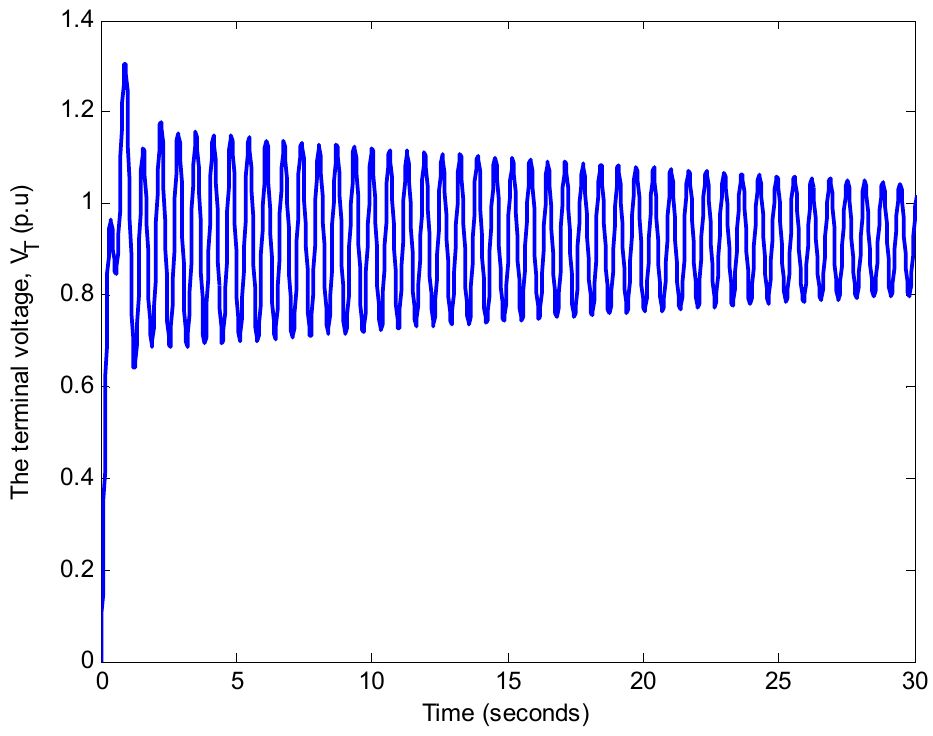
Figure 16. The terminal voltage with a 0.16 s time delay.